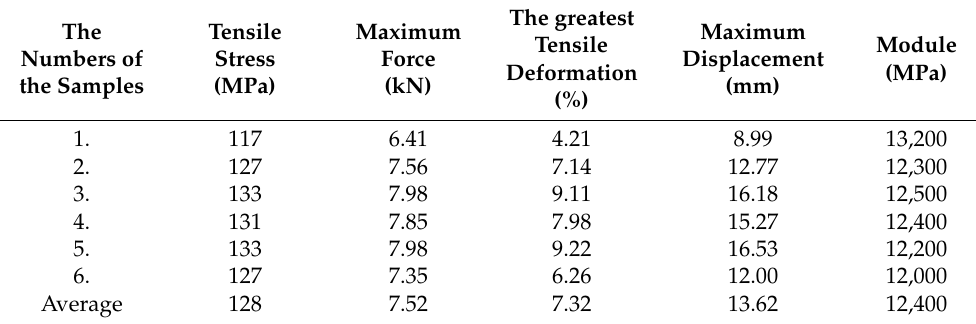
Table 3. Analysis of the obtained test results for the Roving IMS65 composite reinforced laminate, 0/90 ◦